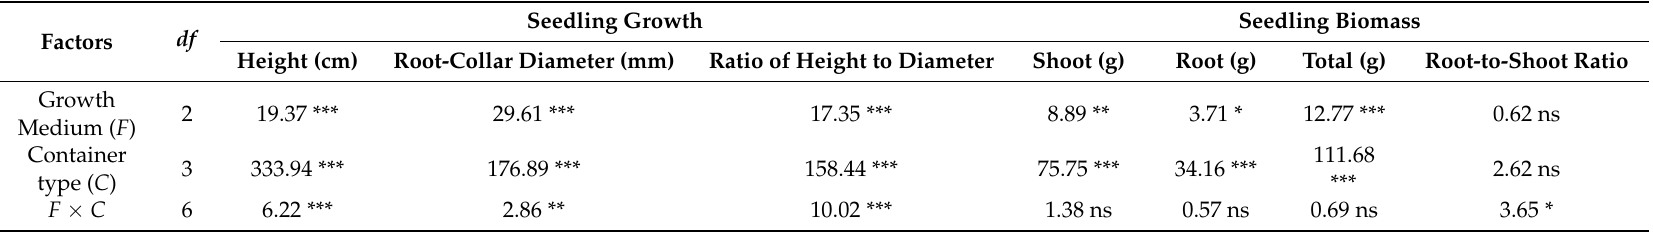
Table 2. F -values and probability levels from the GLM (general linear model) analysis of growth and biomass production of Cyclocarya paliurus seedlings.